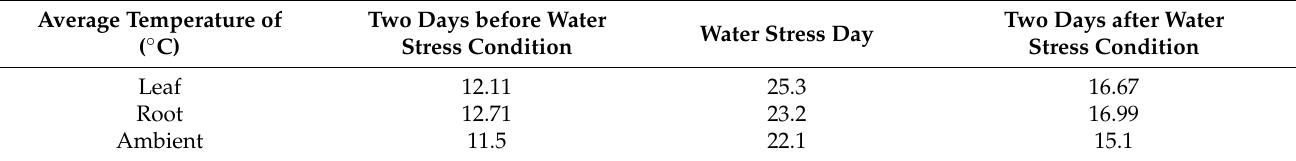
Figure 12. Leaf thermal image capture samples (IR): ( a ) two days before water stress, ( b ) on the day when water stress occurred and ( c ) two days after the water stress. Table 5. Average temperatures obtained during the water stress period.